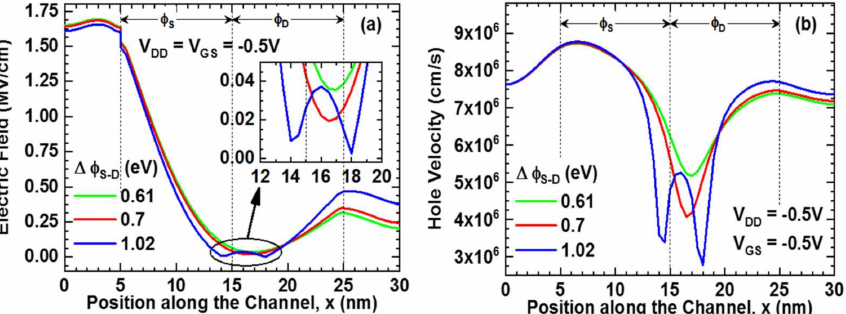
Figure 6. ( a ) Electric Field; inset shows zoomed electric field at the circled region and ( b ) Hole velocity along the channel at on-state (V DD = V GS = − 0.5